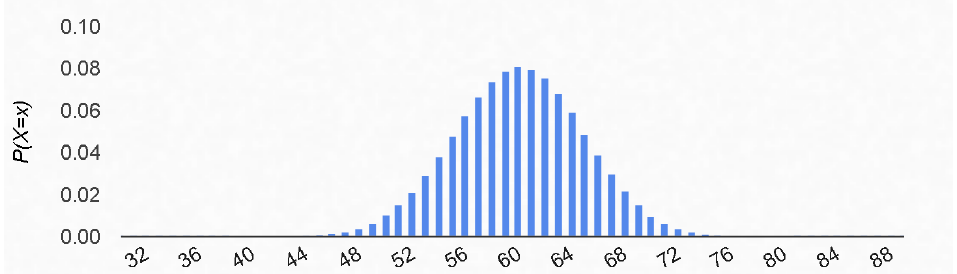
Figure 5. Histogram of 100 binomial recounts (N = 100, p = 0.6) resembling the probability density of the normal